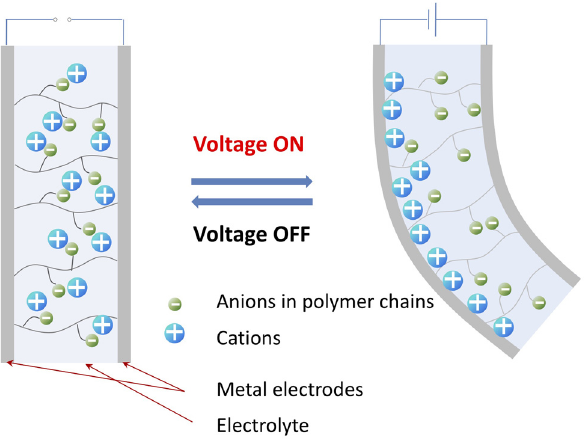
Figure 2: Actuation mechanism of